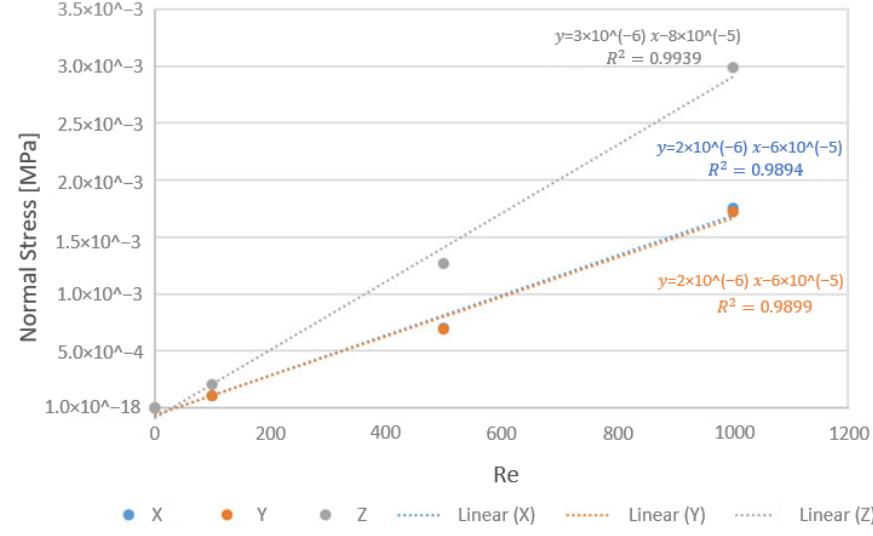
Figure 17. Normal stress as a function of Re.